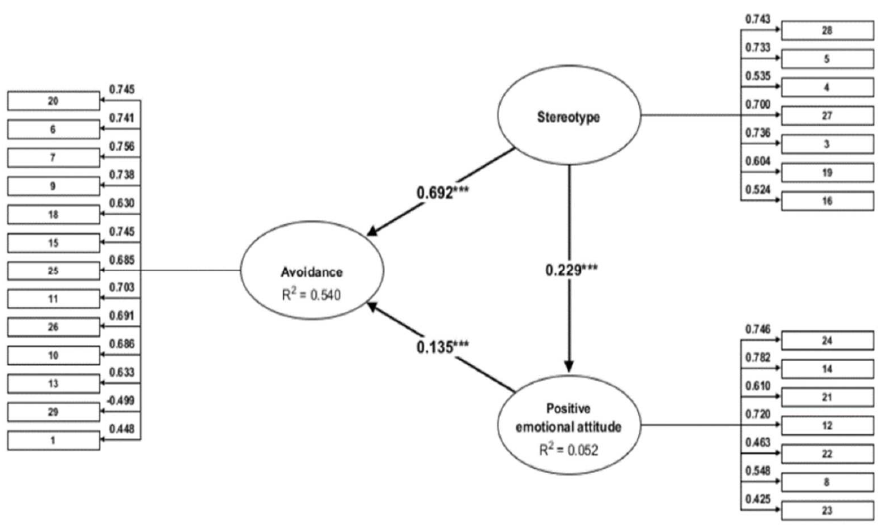
Figure 2. Structural model of FSA Note: *** p < 0.001